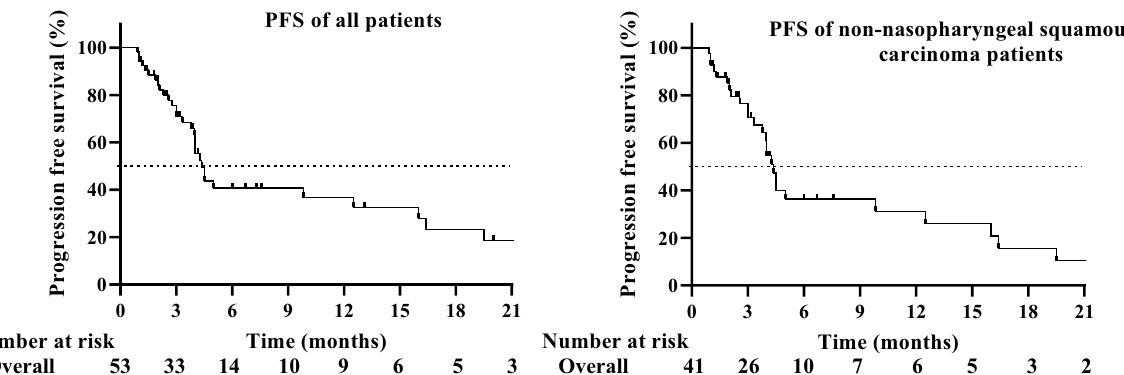
Figure 1. Kaplan–Meier graph for progression-free survival (PFS) of all patients (n = 53) and non- nasopharyngeal squamous cell carcinoma patients (n = 41): median PFS of all people was 4.4 months (95% CI